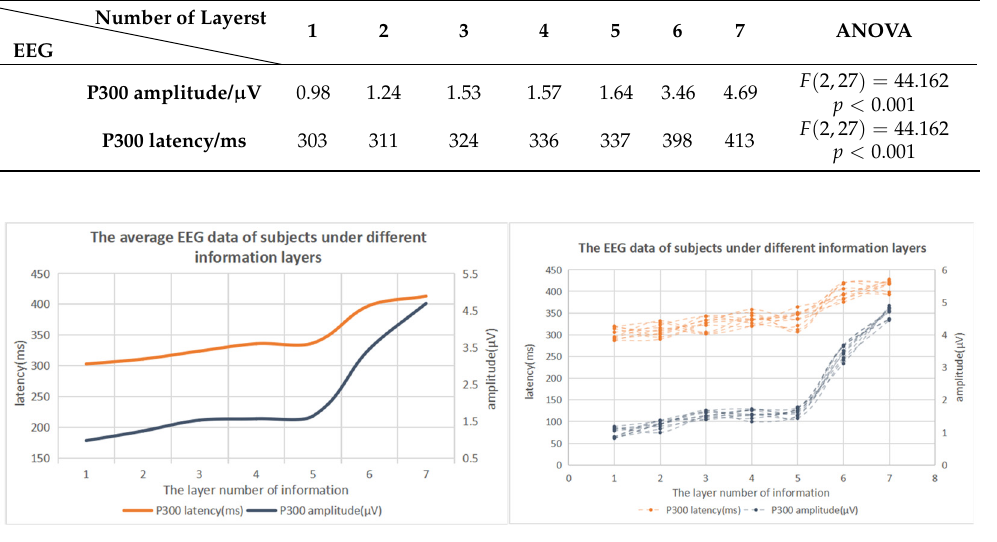
Table 13. Average P300 amplitude and average latency of subjects with different numbers of informa- tion layers.